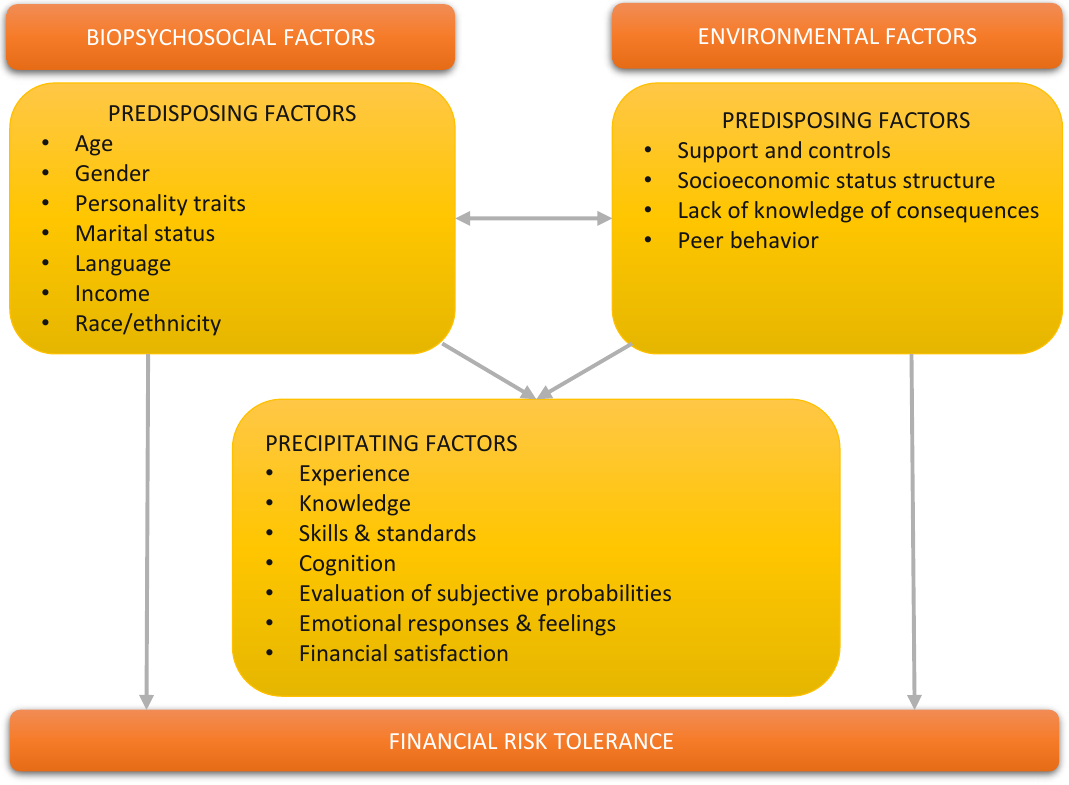
Figure 1. Conceptual model of principal factors affecting financial risk